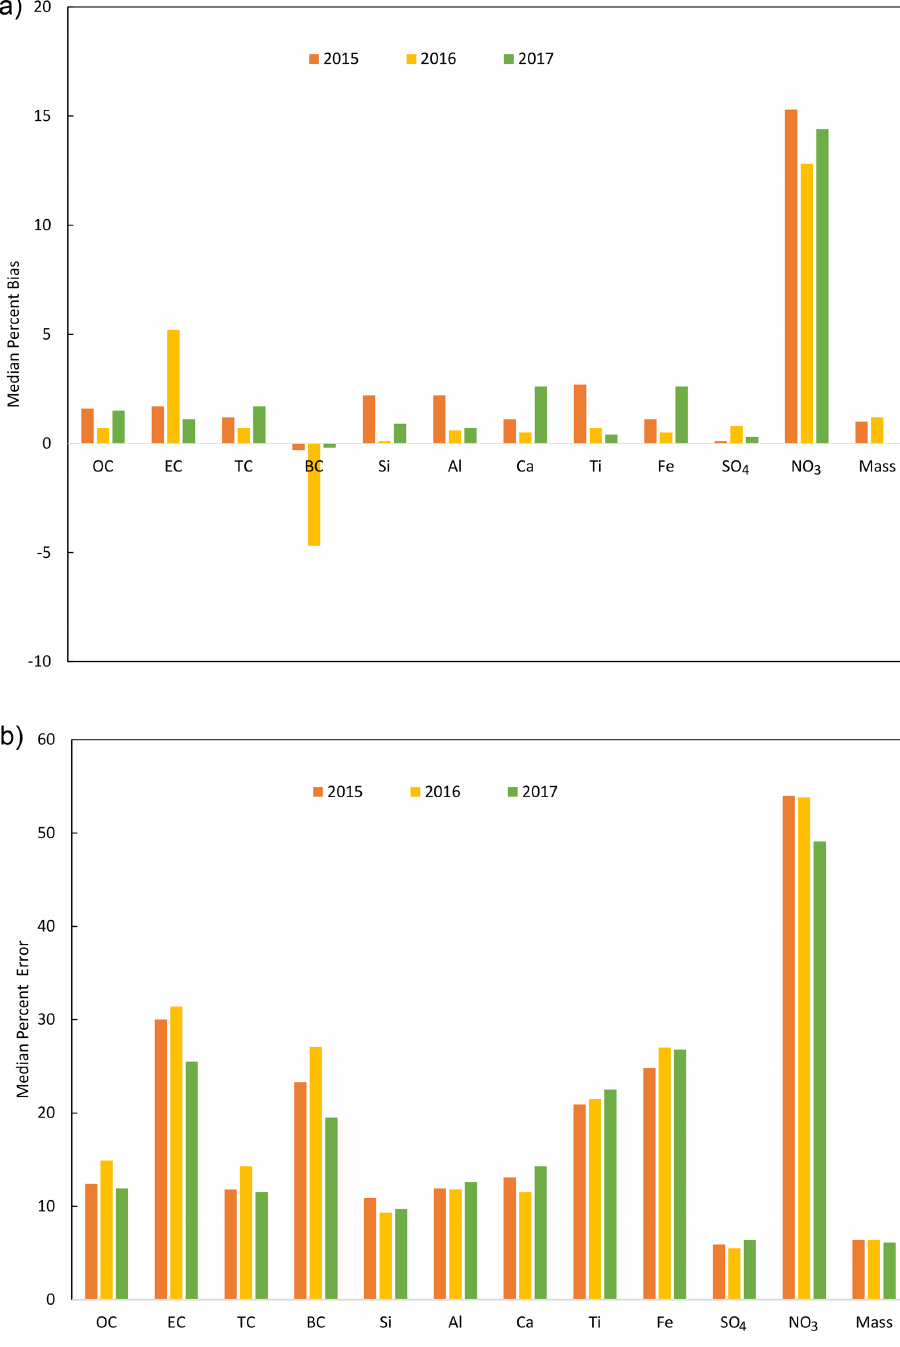
samples which may smooth biases and errors due to changes to atmospheric condition and instrument